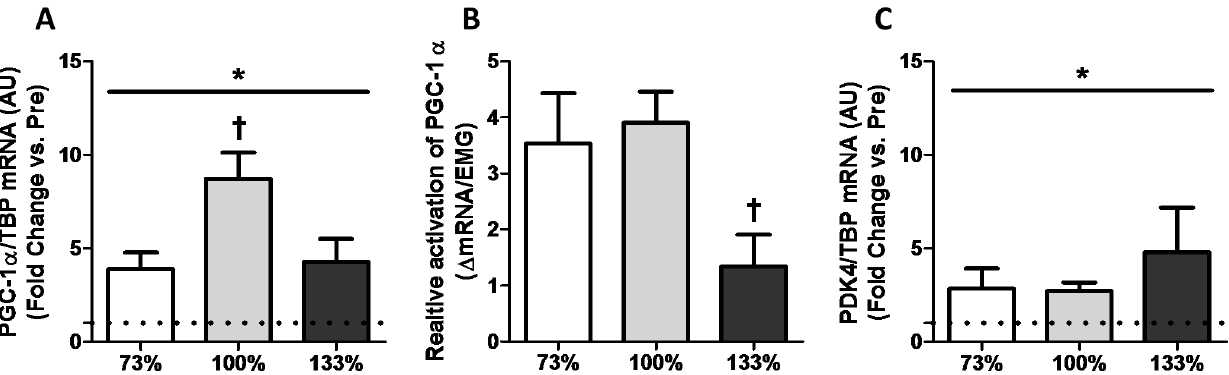
Figure 2. Impact of interval intensity and muscle activation on the expression of PGC-1 a and PDK4. Impact of (A) interval intensity and (B) muscle activation on the expression of PGC-1 a and (C) PDK4. The change in mRNA expression from baseline to post-exercise for interval intensities of 73% (open bars), 100% (grey bars) and 133% (dark bars) is shown. Values presented as Mean 6 SEM. * Significant ( p , 0.05) main effect of time. { Significantly ( p , 0.05) different than other exercise intensities.